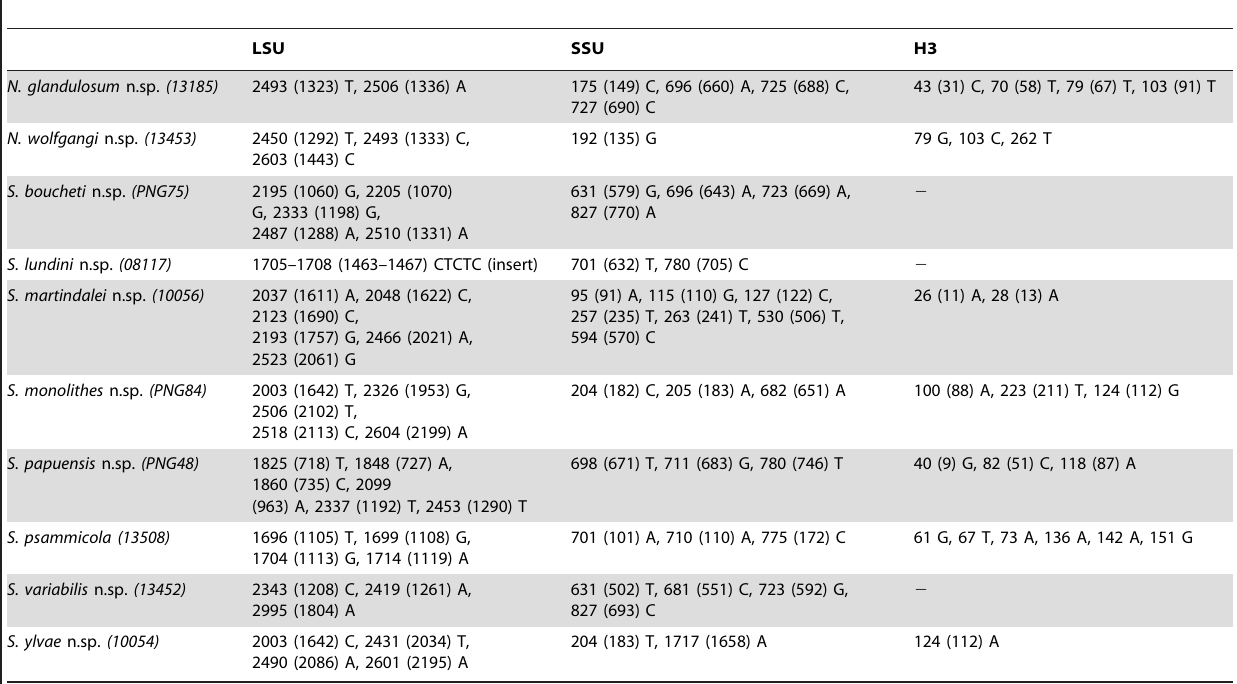
Table 5. Molecular Diagnostic character of all newly described species in the three genes used in this study.